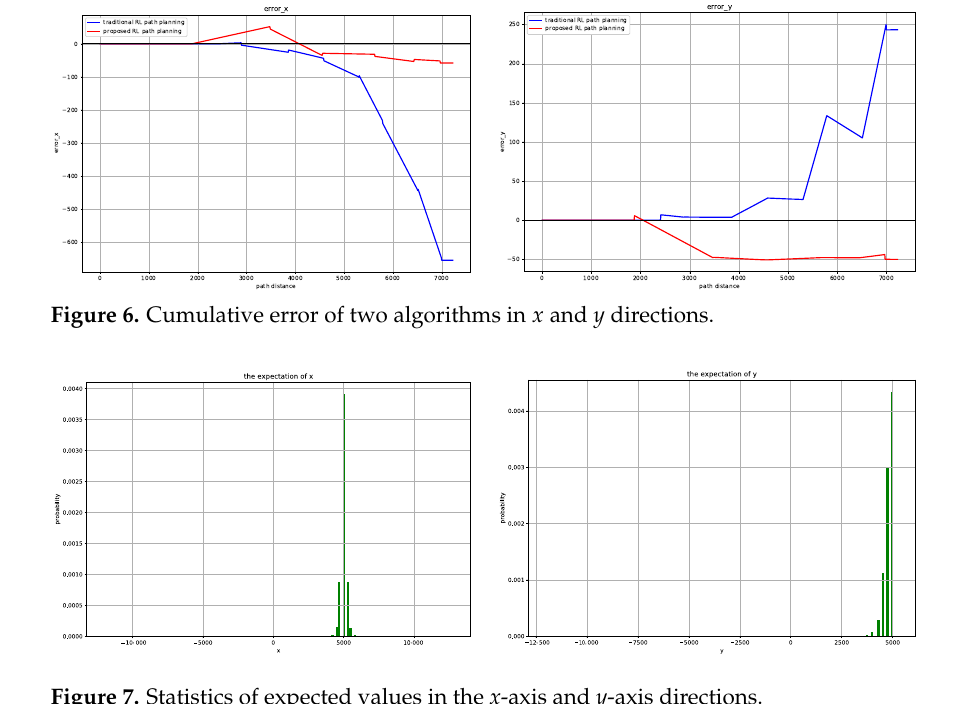
Figure 7. Statistics of expected values in the x -axis and y -axis directions.